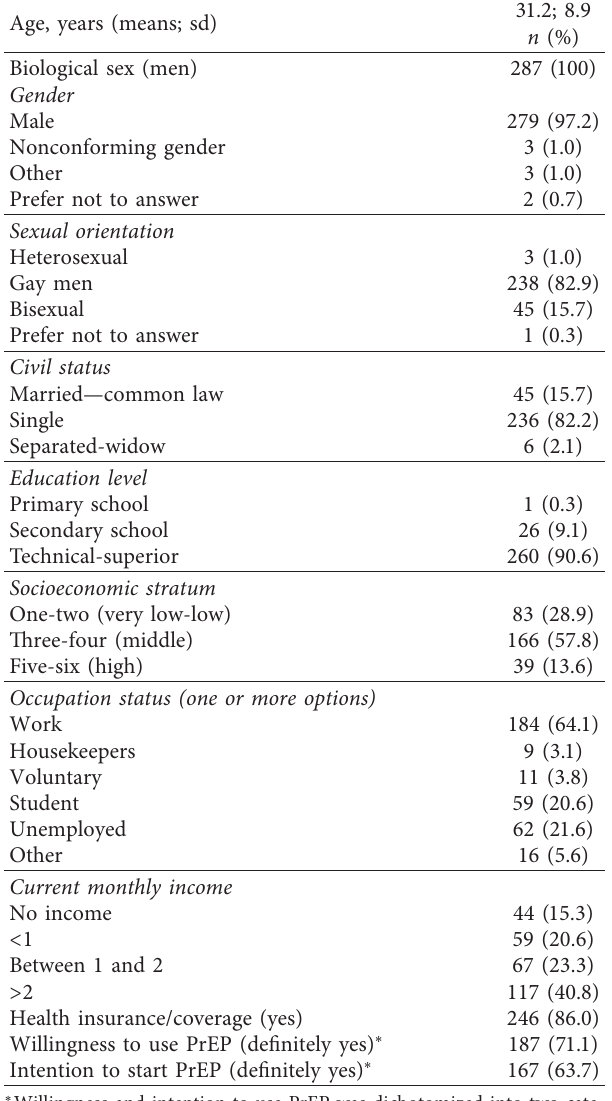
Table 1: Baseline demographic characteristics of the study